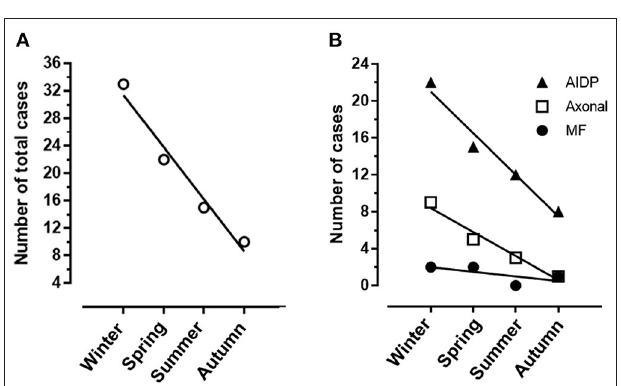
FIGURE 2 | (A) Heterogeneity of Guillain-Barré syndrome (GBS) incidence among seasons with a significant cluster in winter months. (B) Different distribution of demyelinating (AIDP) and axonal GBS among